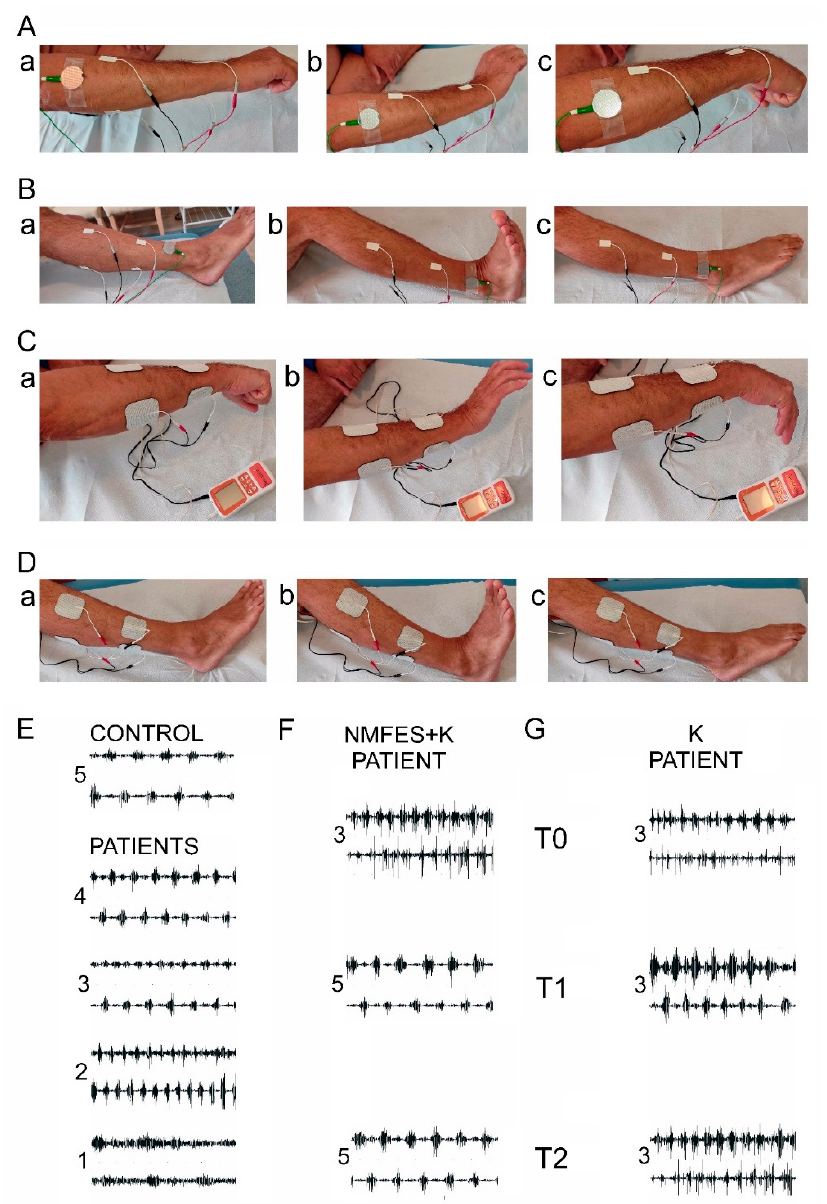
Figure 4. ( A , B ): Distribution of recording electrodes on the surface of the skin over the extensor and flexor muscle groups at the wrist ( A ) and the ankle ( B ) in the neutral position at rest ( a ), during attempts of maximal contraction of the extensors ( b ), and during attempts of maximal contraction of the flexors ( c ). ( C , D ): Location of the stimulating surface electrodes used for NMFES of the antagonistic muscle groups at the wrist ( C ) and the ankle ( D ) at the neutral position ( a ), evoking the extension ( b ), and evoking the flexion ( c ). Examples of EMG recording patterns showing the alternate function of the antagonistic muscle groups acting at the wrist ( E ) under normal conditions (control, 5) and in patients with varying degrees of severity (patients, 4–1) (E5: full alternate, normal activity; E4: slightly disturbed alternate activity; E3: moderate disturbed alternate activity; E2: highly disturbed alternate activity; E1: no alternate activity). Examples of EMG recorded in one of the patients from the NMFES+K group ( F ) and the K group ( G ) before treatment (T0) and in two observation periods (T1: after 21 days of treatment; T2: after 60 days of treatment). Note the improvement of the antagonistic muscle groups acting at the wrist only in the patient from the NMFES+K